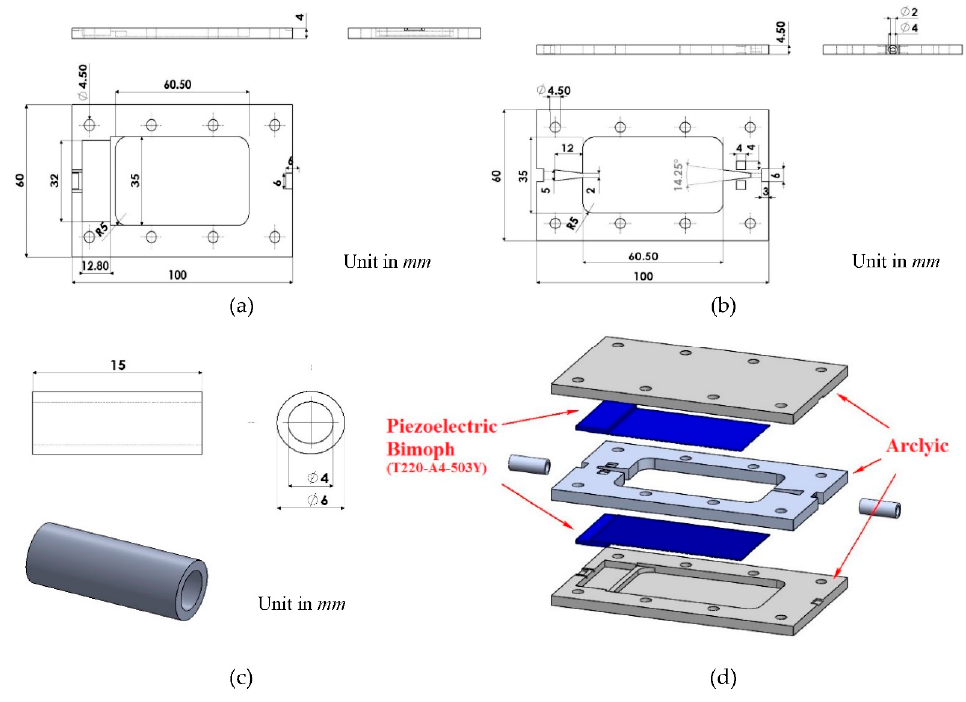
Figure 2. Engineering draft of the ( a ) pump element cover, ( b ) pump element chamber, ( c ) dimensions of inlet and outlet pipes, and ( d ) assembly of proposed pumping element.